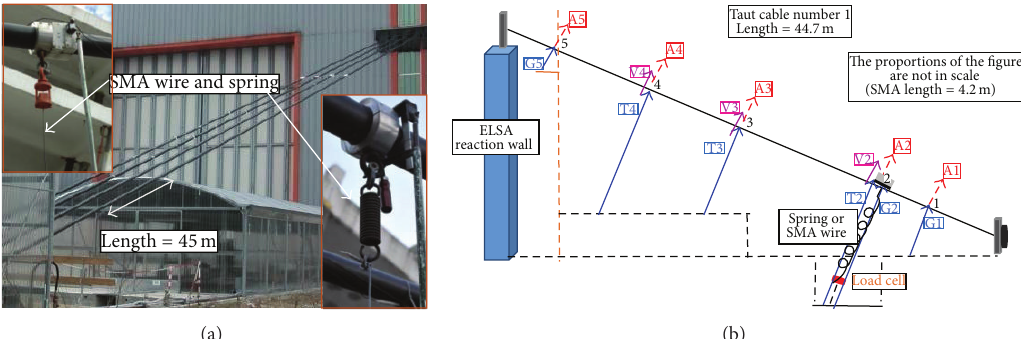
Figure 2: (a) ELSA cable facility with zoomed views of the SSI attachments. (b) Transducers type and positions on the cable no. 1.